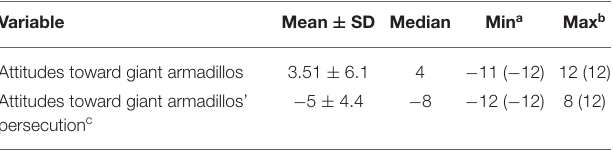
TABLE 3 | Descriptive statistics of beekeepers’ attitudes toward giant armadillos ( Priodontes maximus ) and toward its persecution. Variable